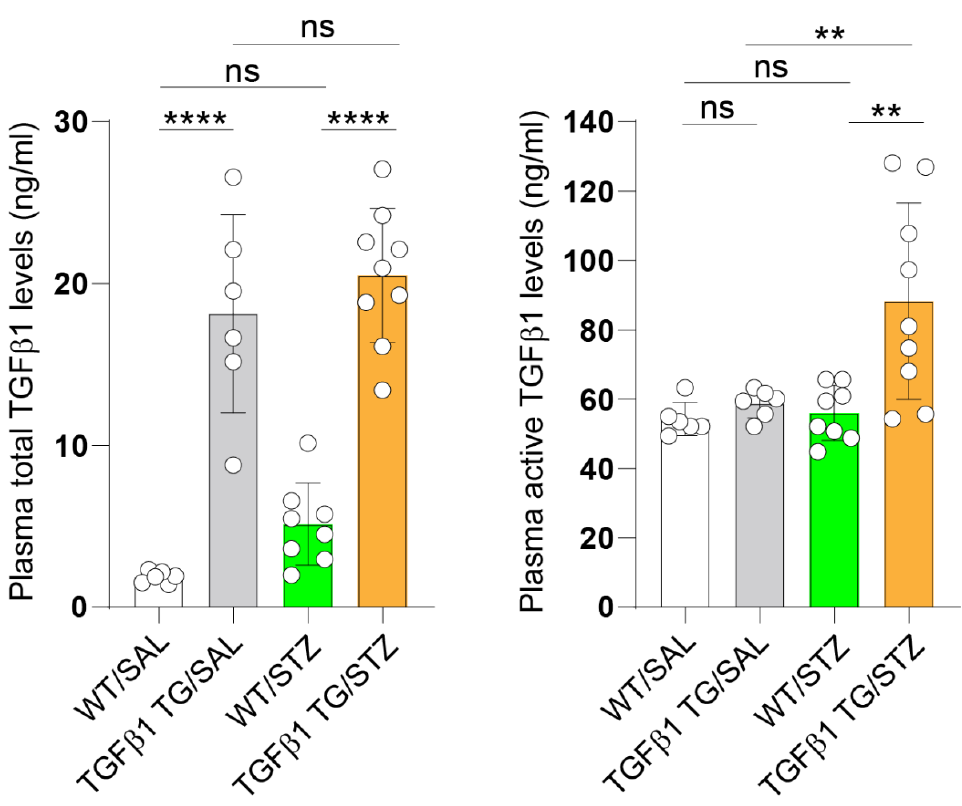
Figure 1. Increased circulating levels of total and active TGFβ1 in TGFβ1 TG mice with diabetes mellitus. The plasma levels of total and active TGFβ1 were measured by immunoassay using a commercial kit. The number of mice were as follows: WT/SAL n = 6, TGFβ1 TG/SAL n = 6, WT/STZ n = 8, TGFβ1 TG/STZ n = 9. Data are expressed as mean ± S.D. Statistical analysis by one-way analysis of variance (ANOVA) with Newman –Keuls’ test. ** p < 0.01; **** p < 0.0001; ns, not significant.